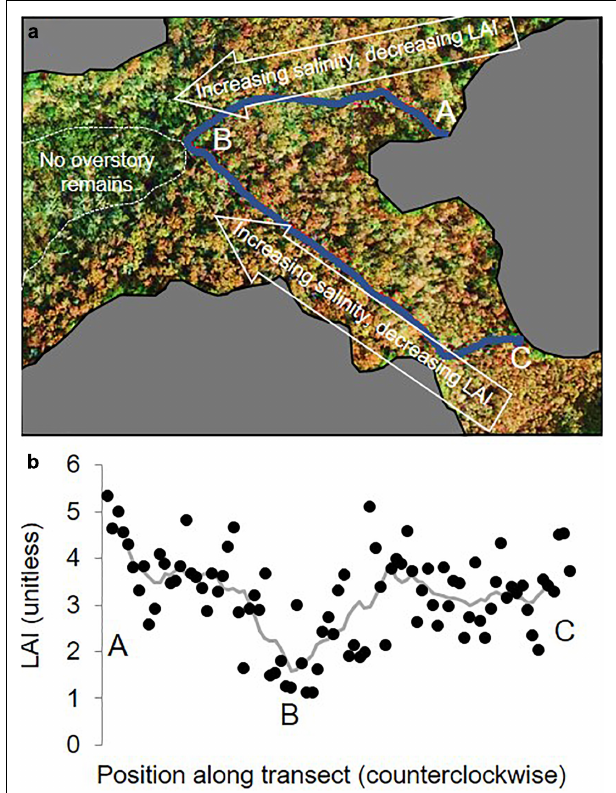
FIGURE 1 | (a) Aerial image of site (with upland areas excluded), showing the boardwalk along which sampling was conducted (in blue) and showing the shift in structure with salinity. The marked “A”, “B”, and “C” correspond with the LAI measurements in (b) , which are measured at 6-m intervals along the site boardwalk. Imagery was downloaded from Google Earth (Google Inc., Mountain View, CA, United States). The gray line in panel (b) is a running mean using a nine-measurement moving